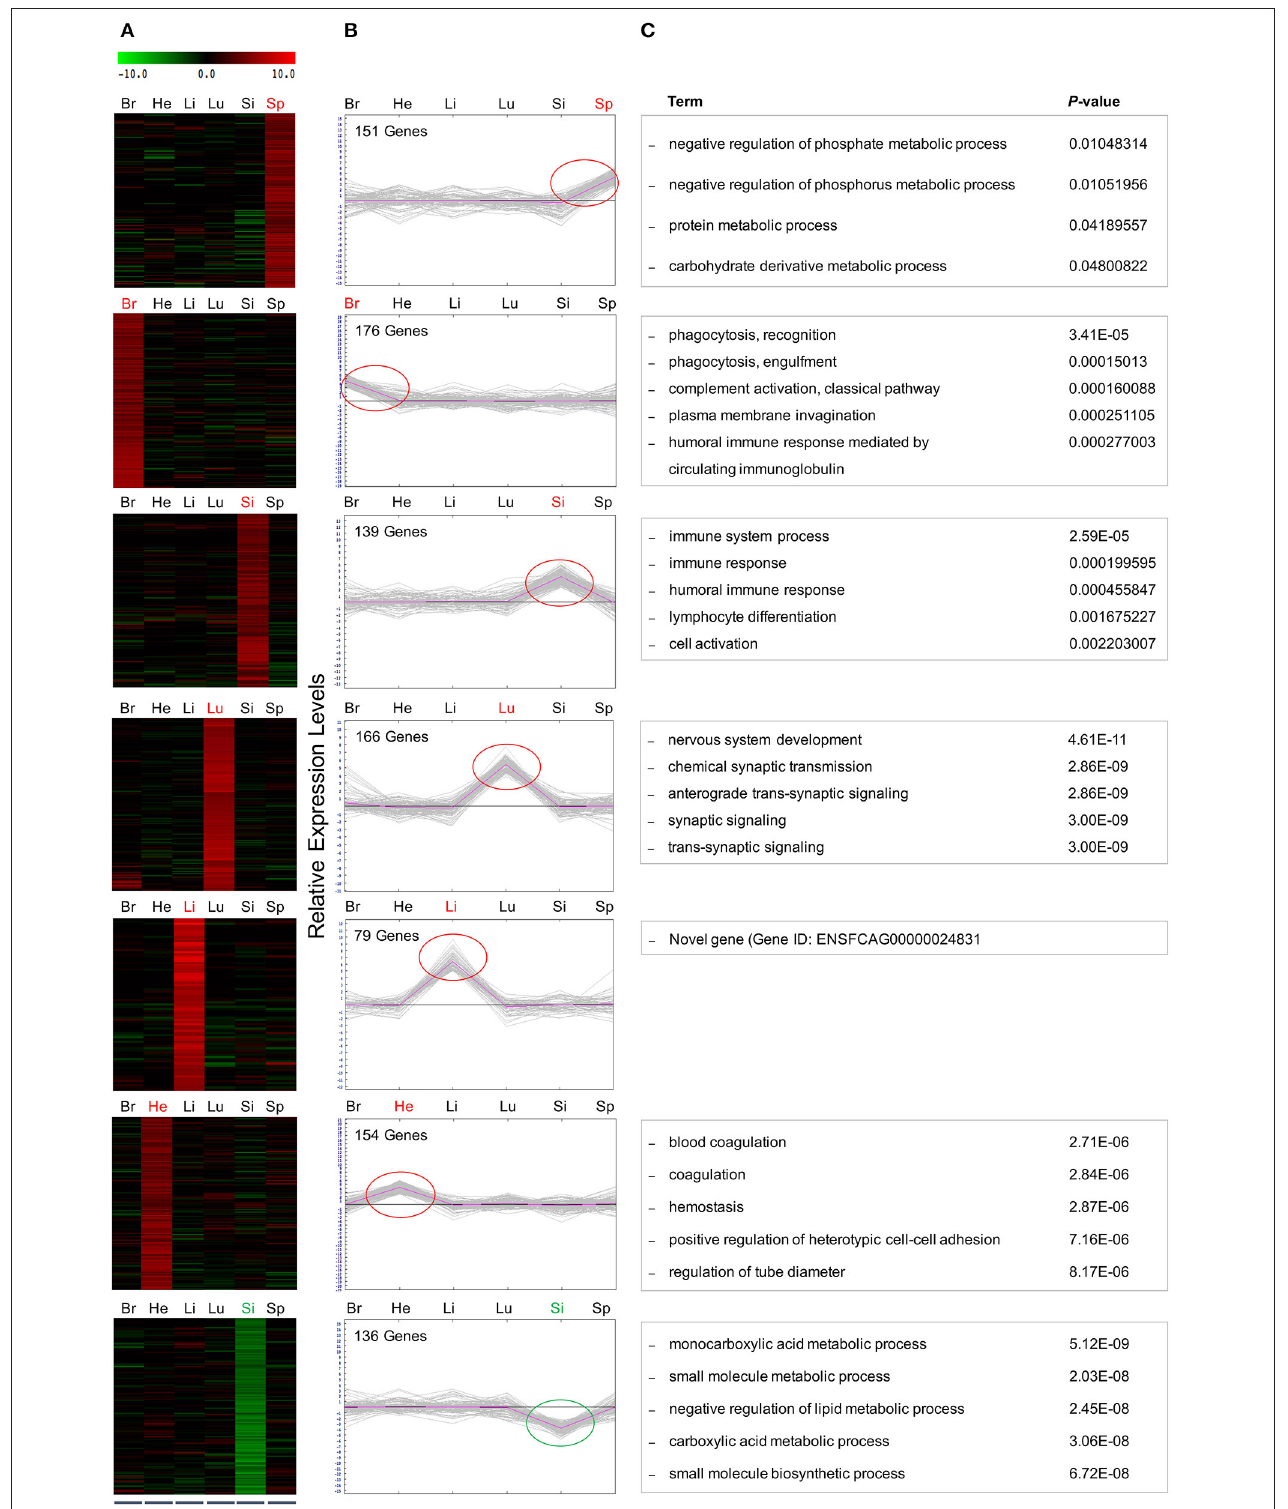
FIGURE 5 | Hierarchical and K-mean clustering analysis of the DEGs within clusters. Differentially expressed, co-regulated genes in each cluster were grouped using k-means clustering. Average cluster size varied considerably among tissues with lung containing the largest cluster with 75 genes. The smallest cluster was found